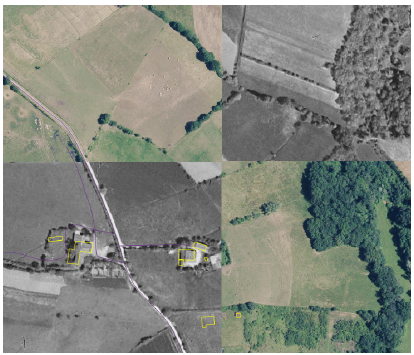
Figure 6. Fabas 1942. ”Coarse absolute” 1942 orthoimage displayed together with the recent reference orthoimage.